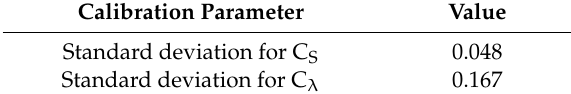
Table 3. Optimized values of the calibration parameters for the Cycle to Cycle Variability CCV model.